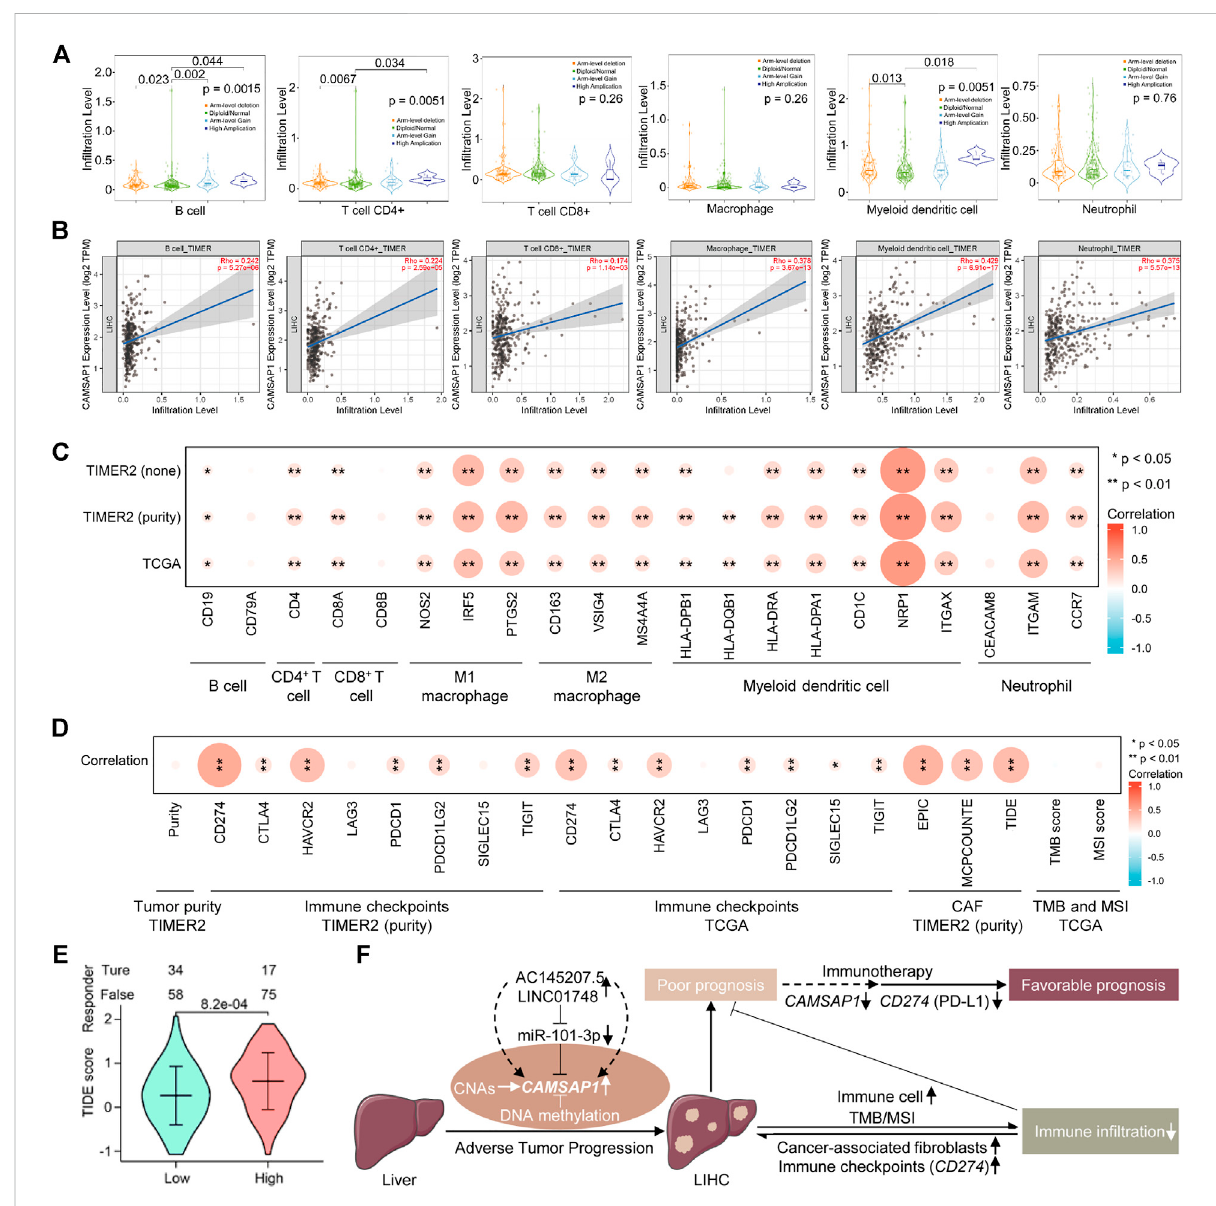
FIGURE 7 CAMSAP1 -associated LIHC is in fi ltrated in the suppressed immune microenvironment. (A) The in fi ltration level of six major immune cells under different copy numbers of CAMSAP1 using TIMER2. (B) Scatter plots of correlation between CAMSAP1 and various immune cells from TIMER2. p < 0.05 indicated a signi fi cant difference. (C,D) Heatmaps ofcorrelation between CAMSAP1 and immunecell markers (C) and immune regulated genes (D) fromTIMER2andTCGA.* p < 0.05,** p < 0.01. (E) Aviolinplotof CAMSAP1 -associatedICBtreatmenteffectbetweenhighandlow